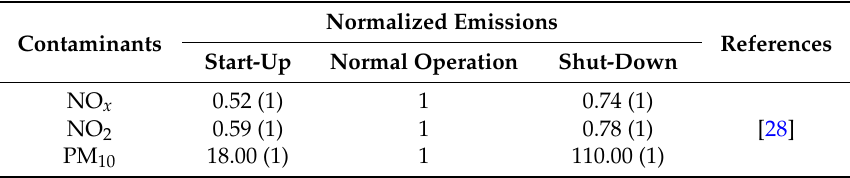
Table 4. Normalized emissions from a liquefied natural gas (LNG) processing facility under start-up, normal, and shut-down operating conditions (number of facilities investigated shown in